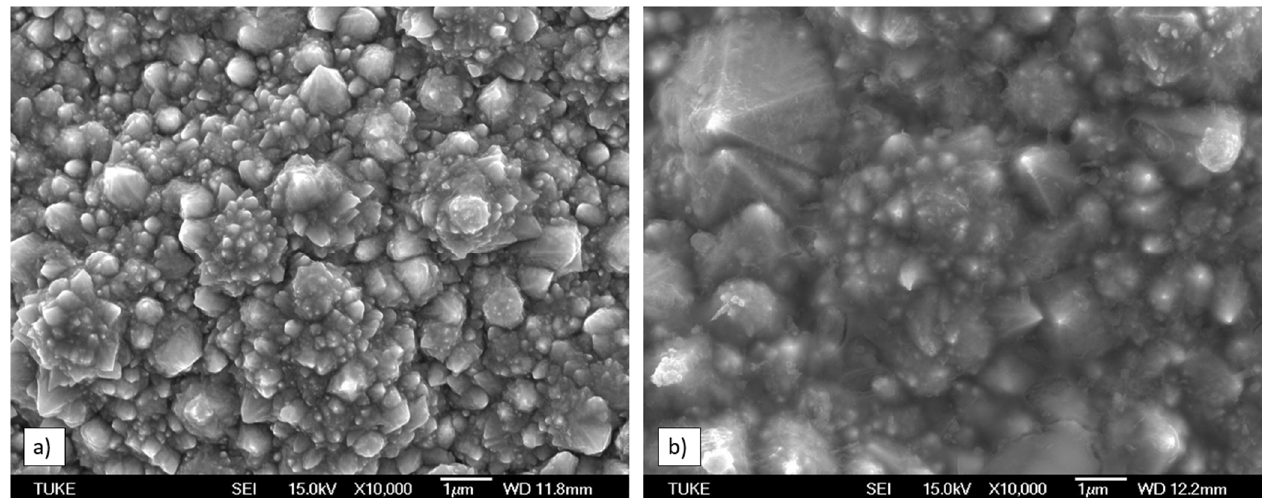
Figure 4. Surface morphology of Ni-Co coatings: ( a ) Sample 3 (with 24.82 wt. % Co deposited at 4 A dm − 2 ); ( b ) Sample 4 (with 13.83 wt. % Co deposited at 6 A dm − 2 ).